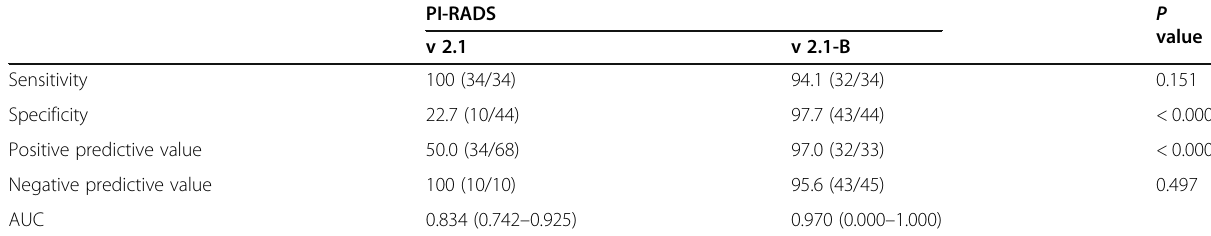
Table 5 Diagnostic performance of transition zone prostate cancer detection between PI-RADS v2.1 and PI-RADS v2.1-B